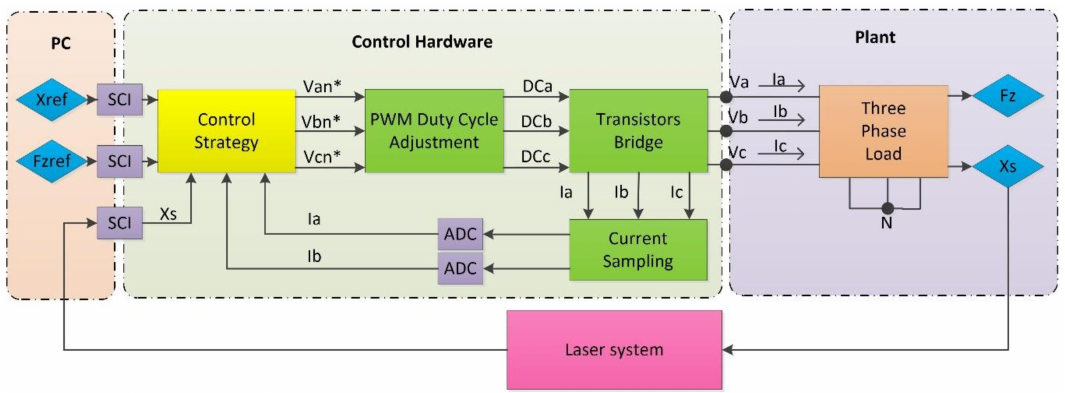
Figure 6. Implementation of control strategy in control